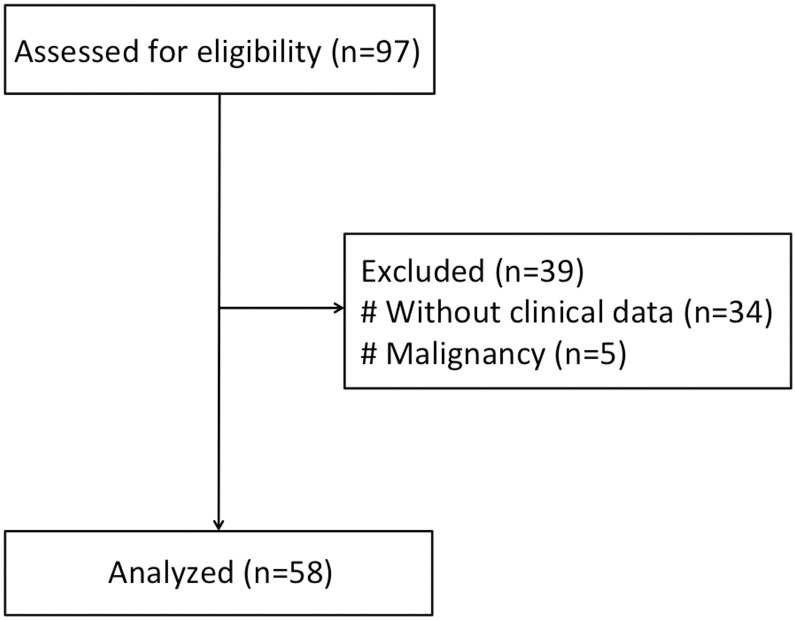
Flow diagram of study subjects.